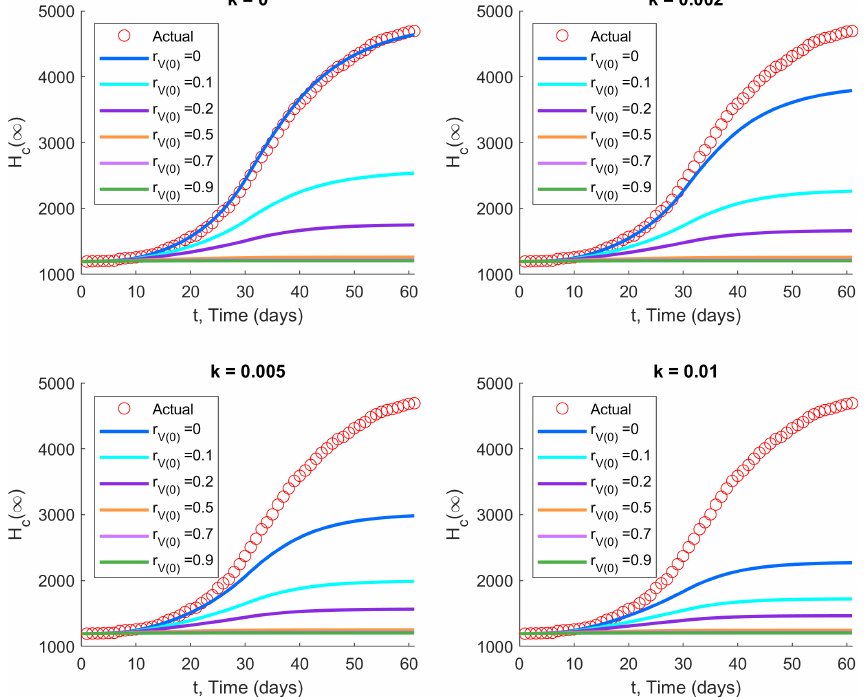
Figure 4. Impact of vaccination with two vaccine types on the third wave of COVID-19 in Hong Kong: ( ε , α , β , γ , δ ) = ( 0.48,0.5,0.14,1,0.1 ) and v e = 0.774, with initial values as in Table 2. Increasing the initial vaccination coverage ( r V ( 0 ) ) and/or the subsequent vaccination rate ( k ) significantly reduces the cumulative number of hospitalizations and